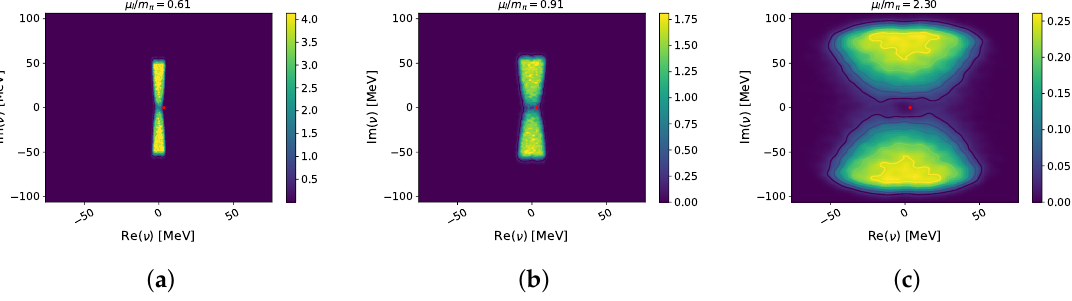
Figure 2. Contour plots of the complex spectrum of the Dirac operator as obtained for a N s = 24, N t = 6 lattice at λ / m ud 0.29, and T = 155 MeV for isospin chemical potentials µ I / m π = 0.61 ( a ), ∼ µ I / m π = 0.91 ( b ), and µ I / m π = 2.30 ( c ). The red dot indicates m ud + i ·